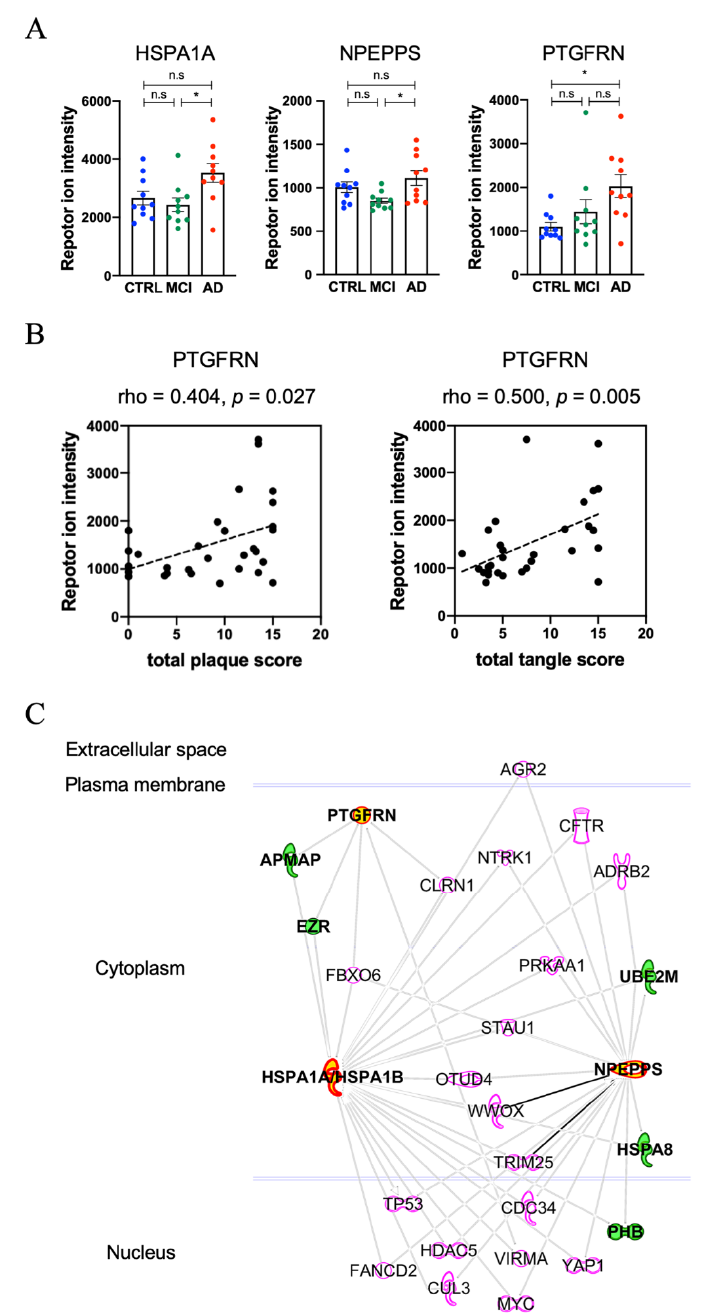
Figure 4. Altered EV molecules during progression from MCI to AD: ( A ) A scatter plot of TMT reporter ion intensity as measured by proteomics per selected candidate protein (HSPA1A, NPEPPS, PTGFRN). One-way ANOVA, followed by Tukey’s-HSD multiple test (n.s: non-significant, * p < 0.05 for AD vs. MCI or AD vs. CTRL). ( B ) A scatter plot showing correlations between demography score and PTGFRN expression level, which was measured using TMT proteomics. The spearman’s rho for total plaque was 0.404 ( p = 0.027), and for total tangle was 0.500 ( p = 0.005). ( C ) Protein–Protein interaction networks of three candidate proteins identified by IPA. The red symbols represent three candidate proteins (HSPA1A, NPEPPS and PTGFRN), while the green symbols represent proteins identified by TMT-labeling